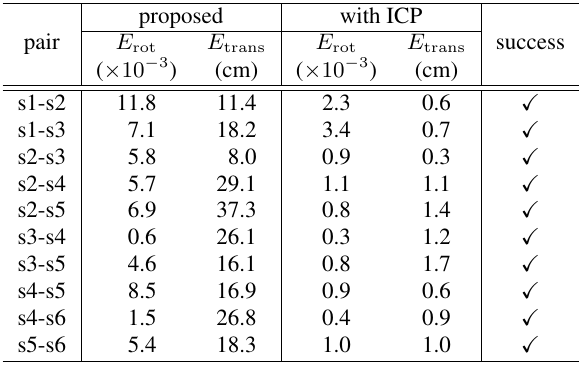
Table 4. Ratios of computation-times of proposed method to